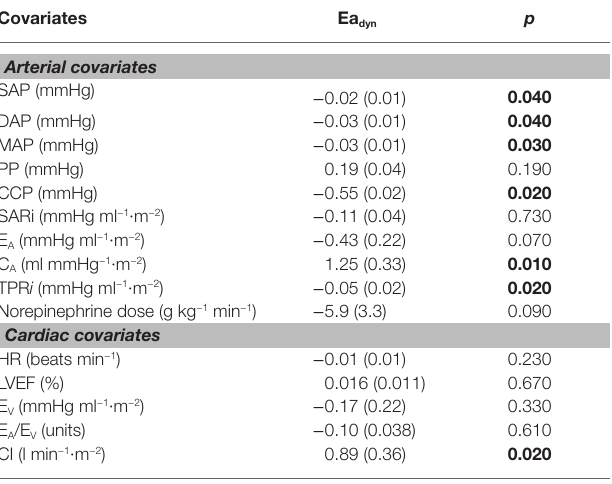
TABLE 3 | Estimated values of fixed effects (arterial load and cardiac parameters) on Ea dyn according to a linear mixed-effects model analysis. Covariates Ea dyn p Arterial covariates SAP (mmHg) − 0.02